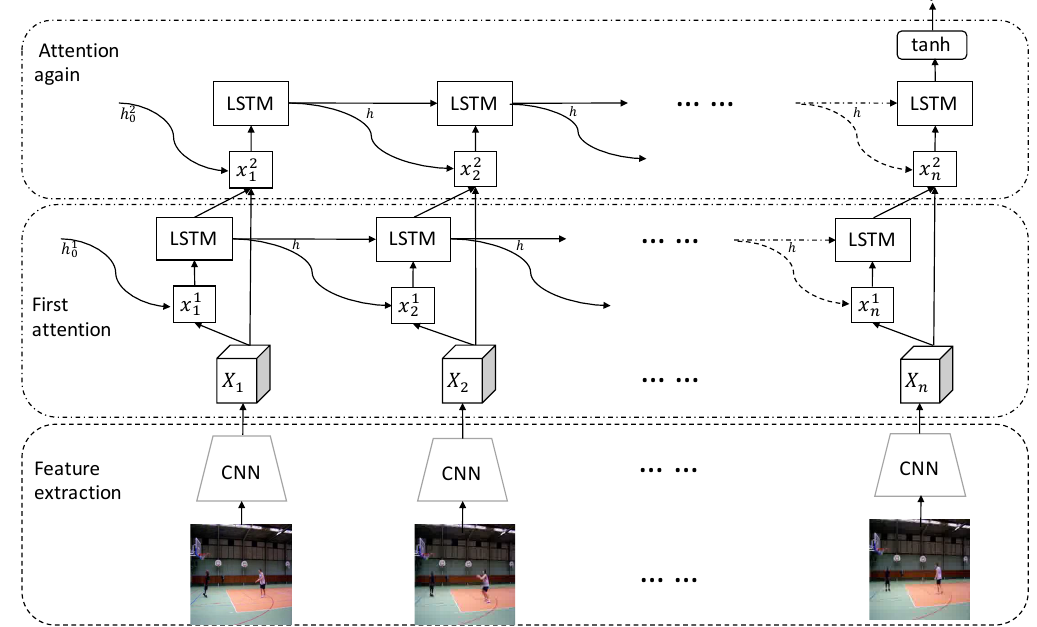
The architecture of the proposed recurrent attention convolutional neural network (RACNN) model. It contain three major components: (1) convolutional feature extraction; (2) long short-term memory (LSTM) sequence modeling and attention model; and (3) “attention-again” model. convolutional neural networks (CNNs) encode the input video frames into feature sequences. Traditional attention model in bottom layer refine the input feature sequences. The proposed model “attention-again” will get more information from input and hidden